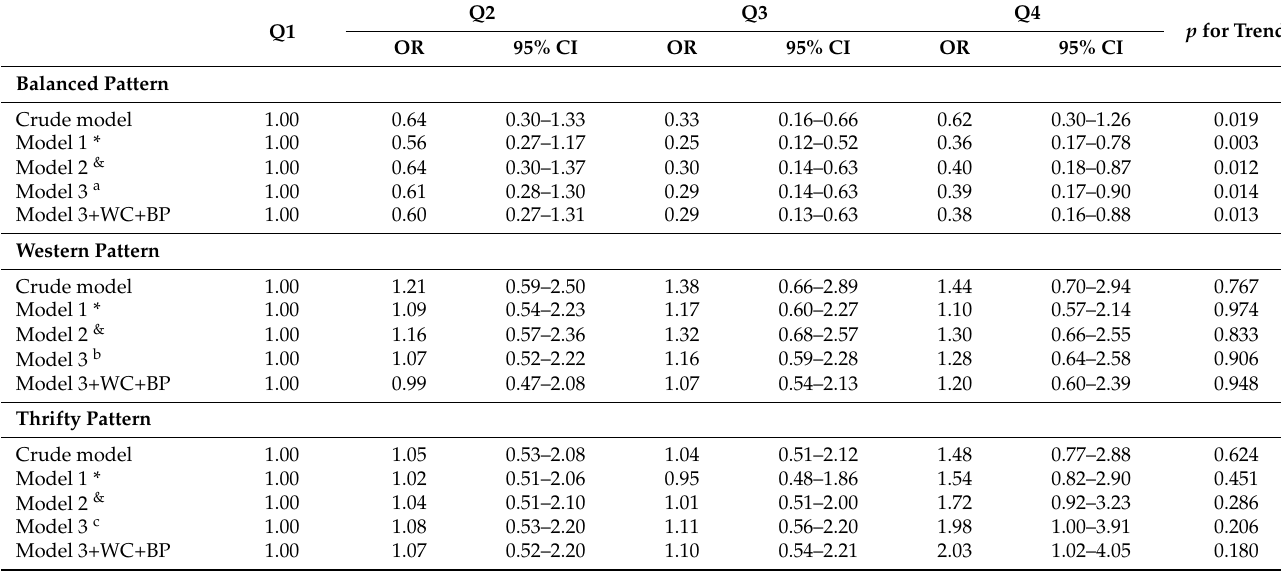
Table 8. Association between low HDL-C and quartiles of dietary patterns in the older participants by BMI subgroups (BMI >= 27.1 kg/m 2